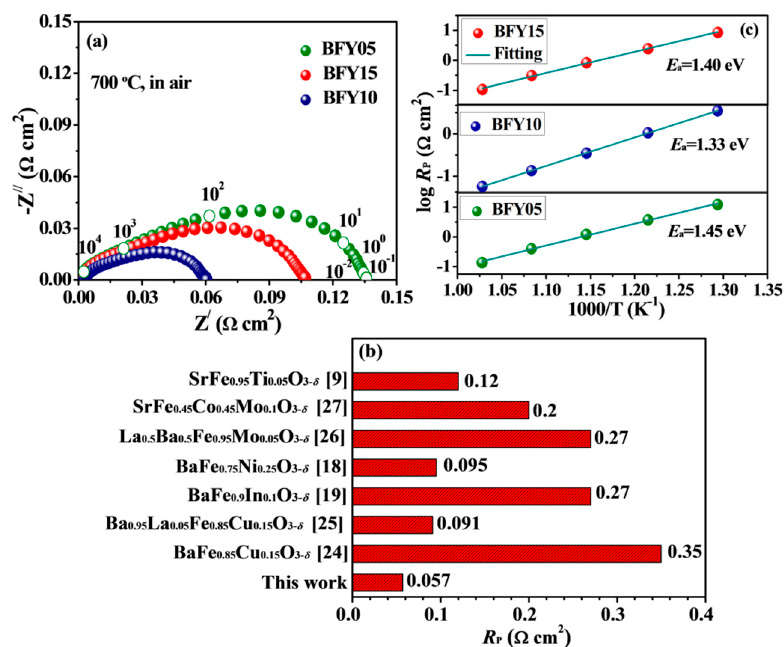
Figure 4. ( a ) Impedance spectra of BFY x measured at 700 °C; ( b ) Comparison of R P for different Fe- based perovskite cathodes at 700 °C; ( c ) Arrhenius plots of R p for BFY x cathodes.